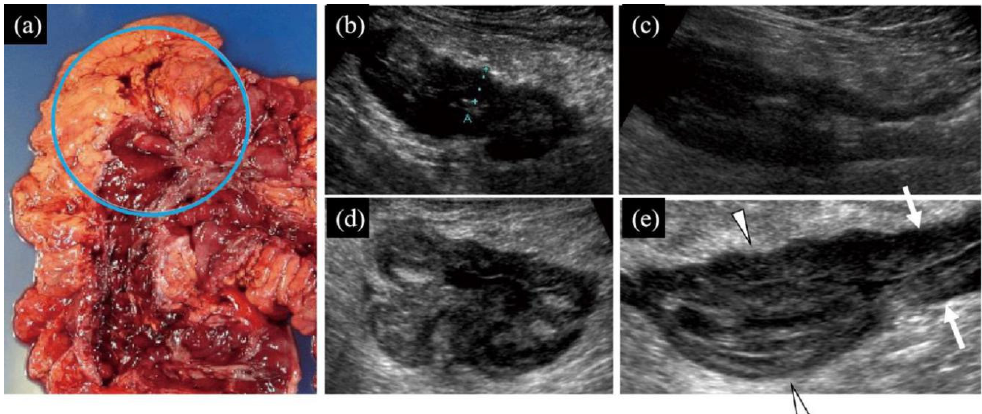
mucosal layers; (2) thickening of the submucosal layer; (3) irregularity of the mucous surface; (4) increased fat wrapping around the bowel wall; and (5) absence of fistula signs.